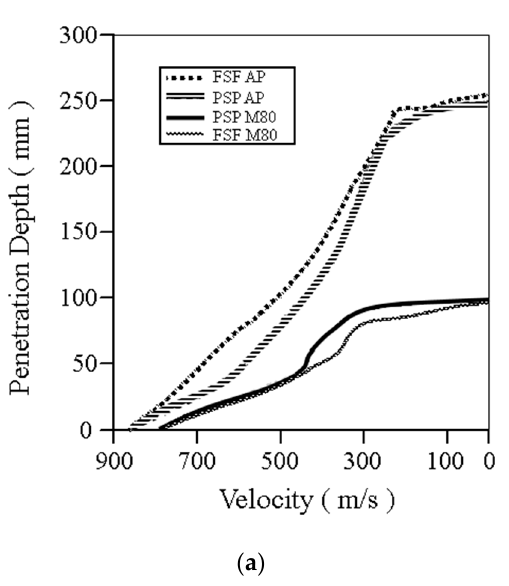
Figure 9. Penetration depth with respect to ( a ) velocity and ( b ) time.